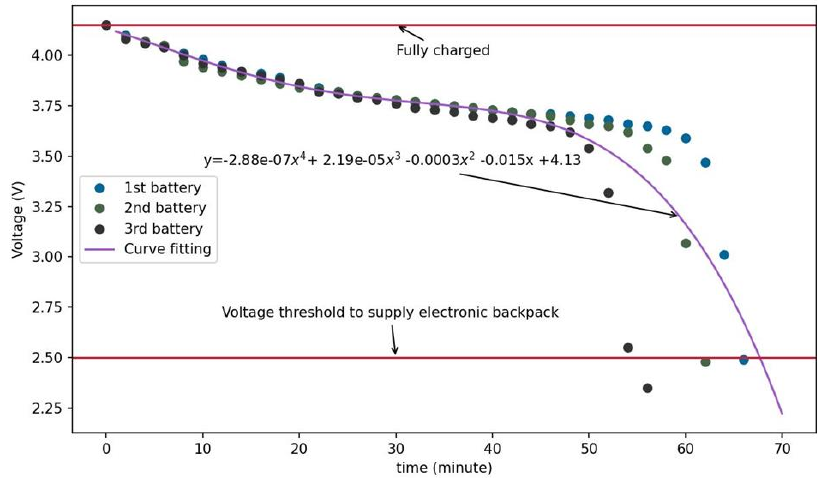
Figure 20. The measured voltage drops of the LiPo batteries.